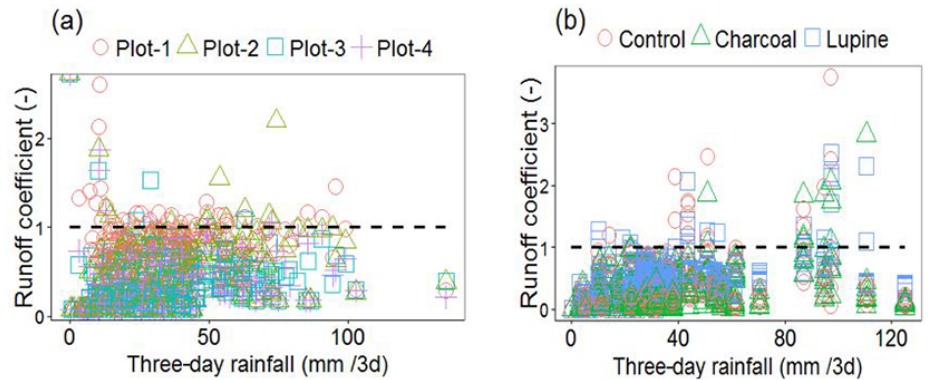
Figure 4. Runoff coefficients computed from observations from long-term monitoring plots (3m length, 1m width) (a) and plots in 2012 and 2013 (b) . The black-dashed horizontal line represents R coef = 1.